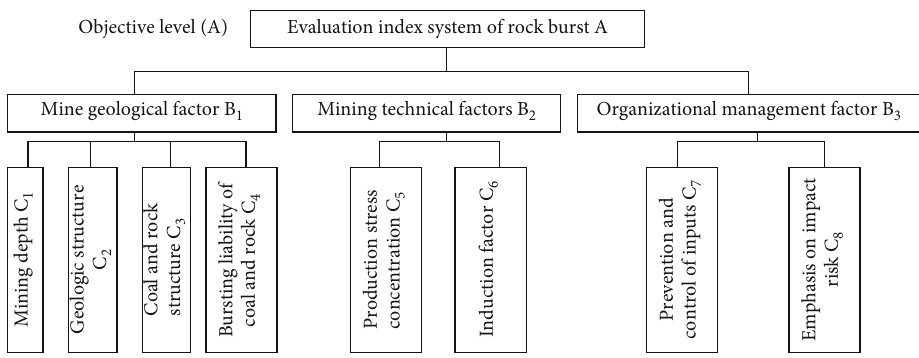
Figure 1: Evaluation index system of coal bursting pressure. Table 4: Mining depth classi fi